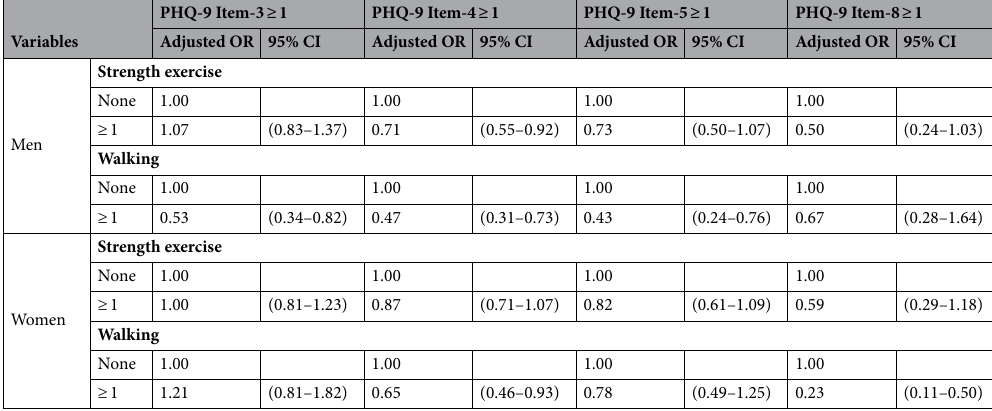
Table 5. Dependent subgroup analysis of the association among strength exercise , walking and somatic symptoms items of PHQ-9. PHQ-9 patient health questionnaire-9, OR odds ratio, CI confidence interval.